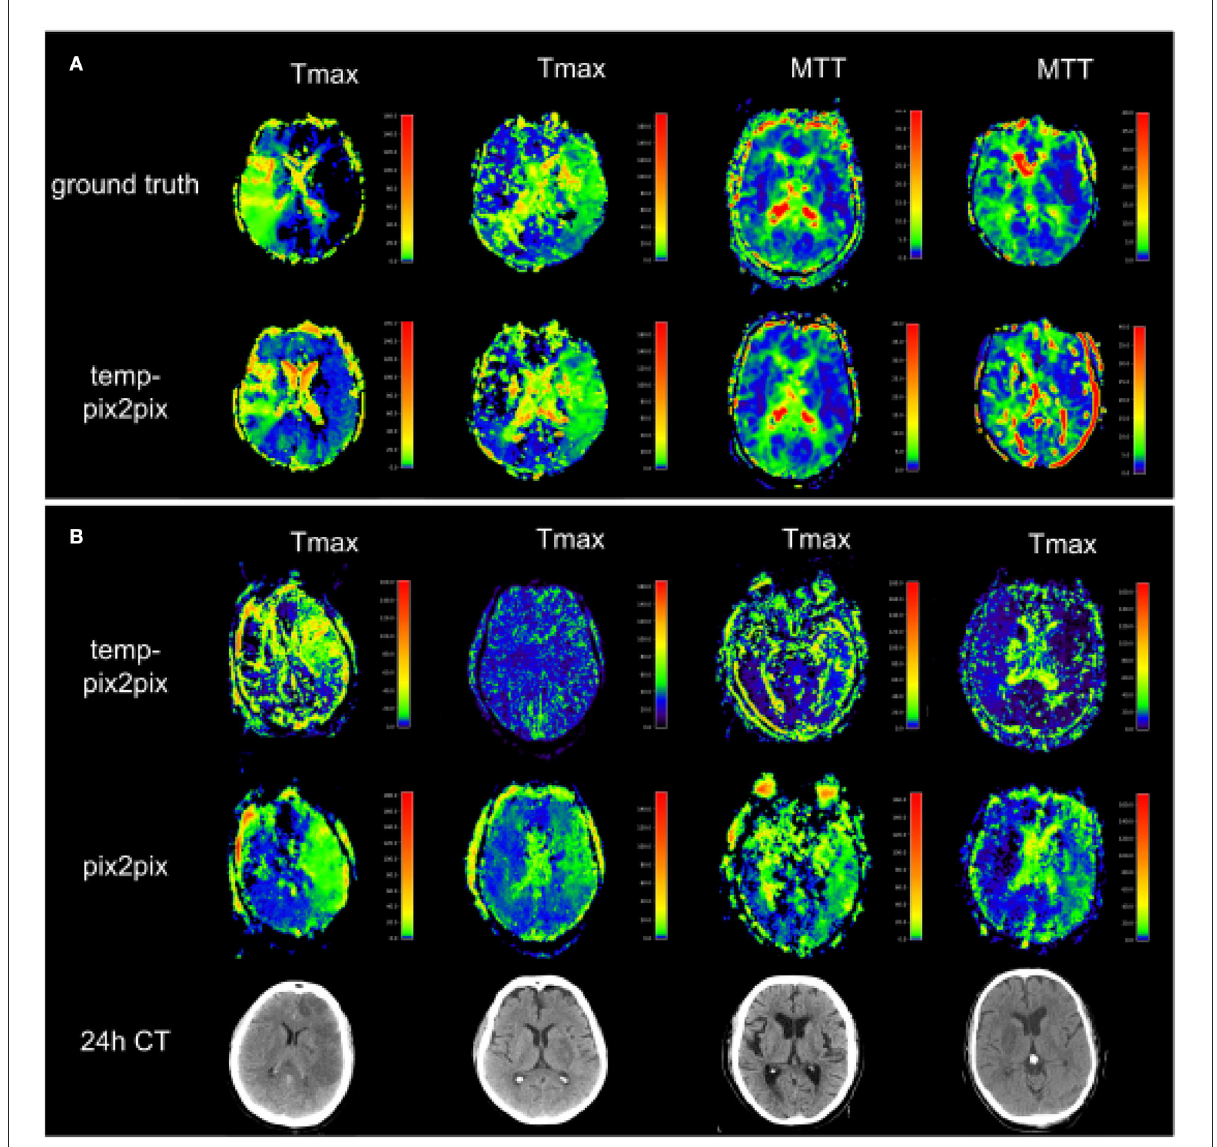
FIGURE8 Two patients with the poorest performance according to the metrics for each of the two datasets (A) and patients for which no AIF could be computed (B) . (A) The first and second columns show Tmax for two patients with acute stroke. Whereas the synthesized image in the first column does not fully capture the hypoperfused areas, the generated image in the second column looks quite close to the ground truth. Columns three and four show MTT for two PEGASUS patients. While the generated image in the third column shows less noise than the ground truth, the GAN introduced noise in the fourth column in the synthesized image. (B) Four Tmax maps generated by temp-pix2pix (upper row) and pix2pix (lower row) for cases from the acute stroke data for which no AIF could be computed, and thus with conventional methods not imaging would be available. To get an estimate of the true lesion, 24 h CT is plotted in the lower row. Note that for the CT images, only 2D visualizations were available. Thus, they are not aligned with the perfusion parameter map. Since motion artifacts affect the quality of the time series, in these cases the baseline pix2pix performs better than the